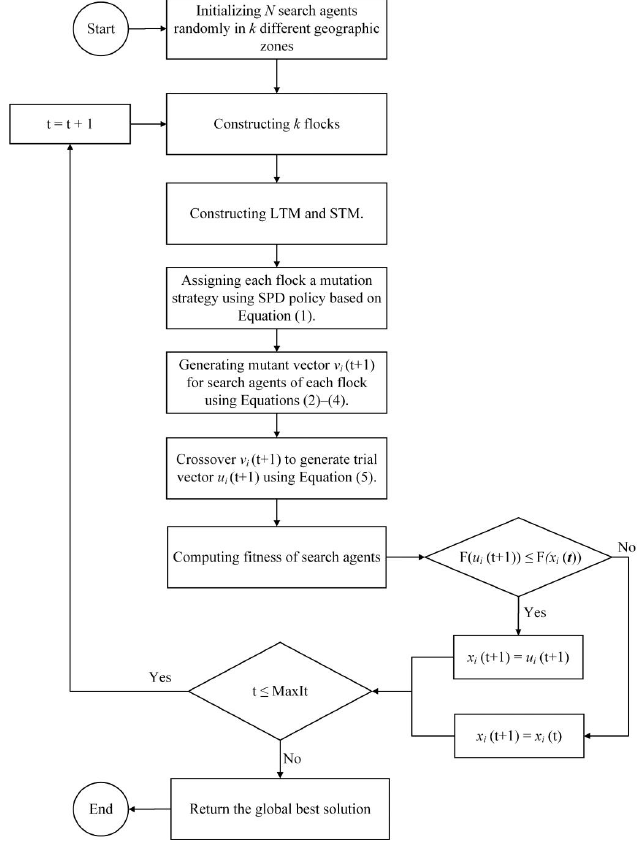
Figure 2. Flowchart of the